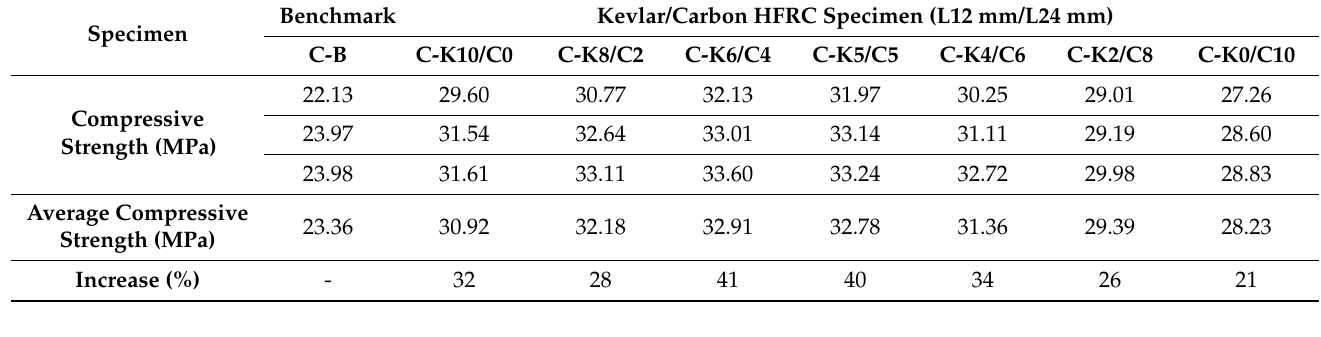
Table 4. Compressive strengths of benchmark and Kevlar/carbon HFRC specimens.